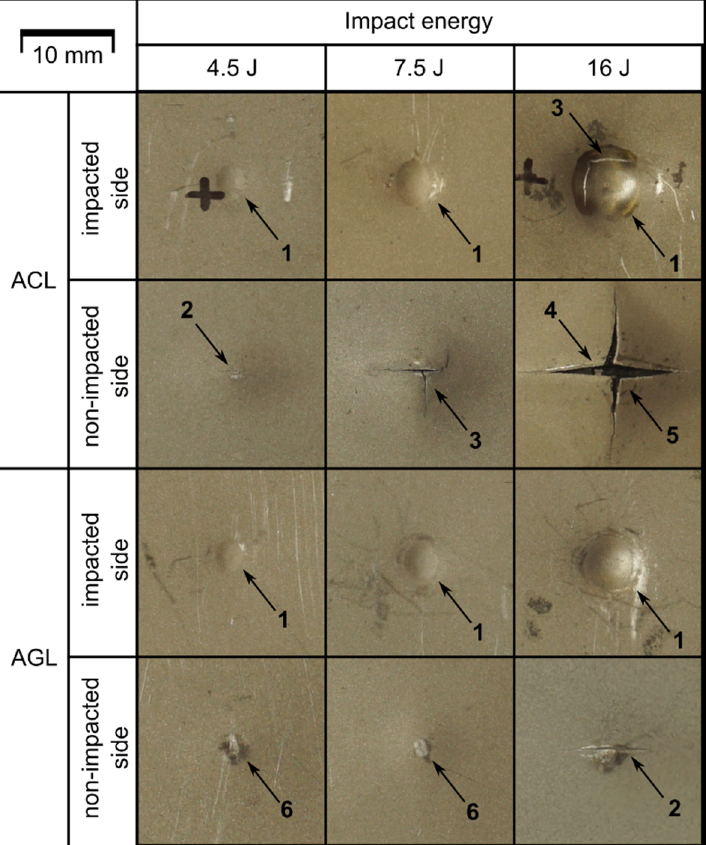
Figure 4. Comparison of FML plates damaged by LVI: close-ups of impact area on impacted and non-impacted sides. For the analysed plates, the following forms of damage were recognized: im- pact dent (1), minor cracks of metal layer (2), extensive cracks of metal layer (3), fibre cracks (4), petalling (5), plastic deformation of bo tt om metal layer (6).